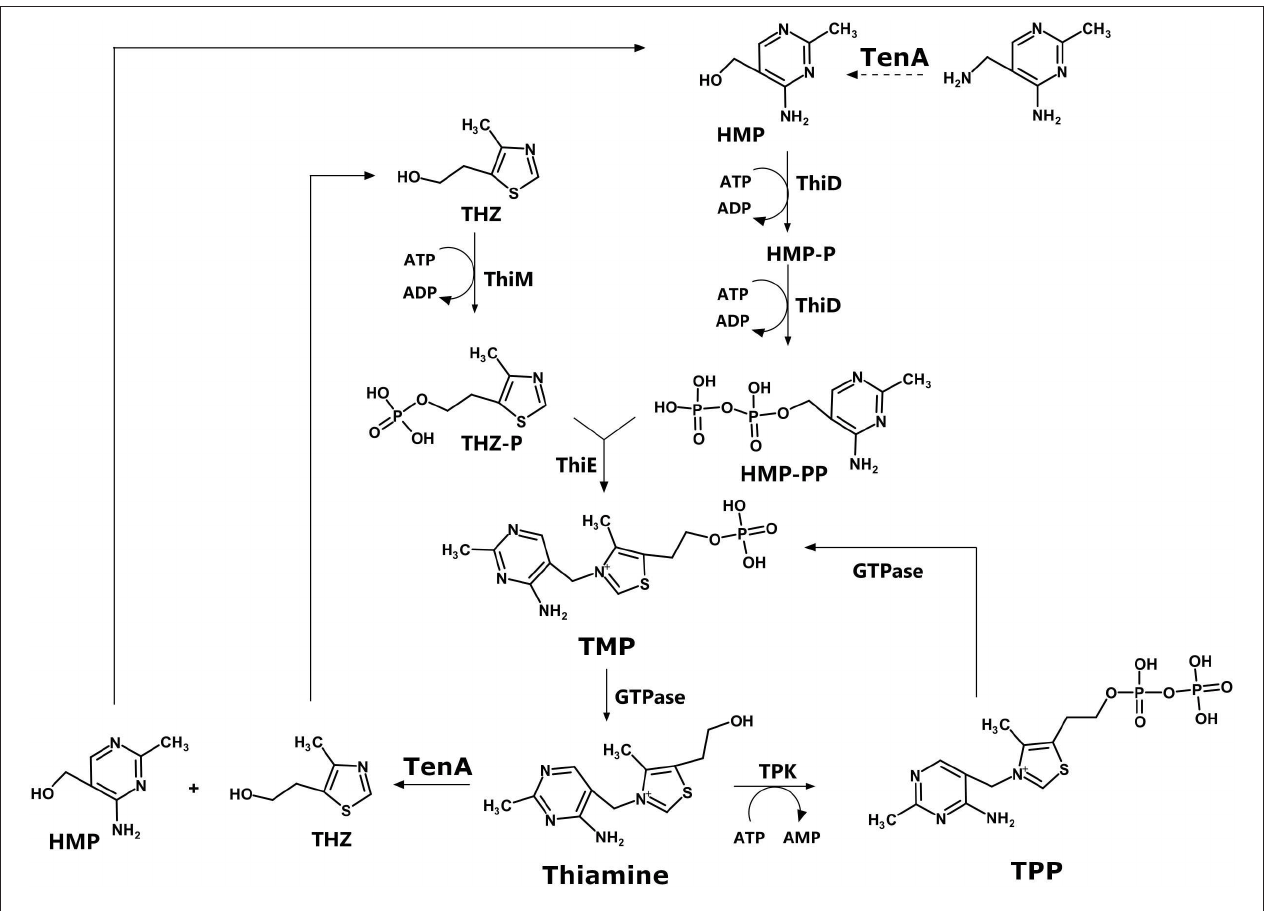
FIGURE 1 | Thiamine biosynthesis pathway.